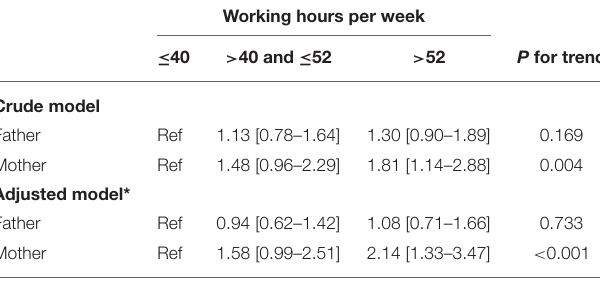
TABLE 5 | Logistic regression analysis for dyslipidemia (low-density lipoprotein cholesterol ≥ 130 mg/dl) in the participant children by working hours of the father or mother, stratified with educational level of